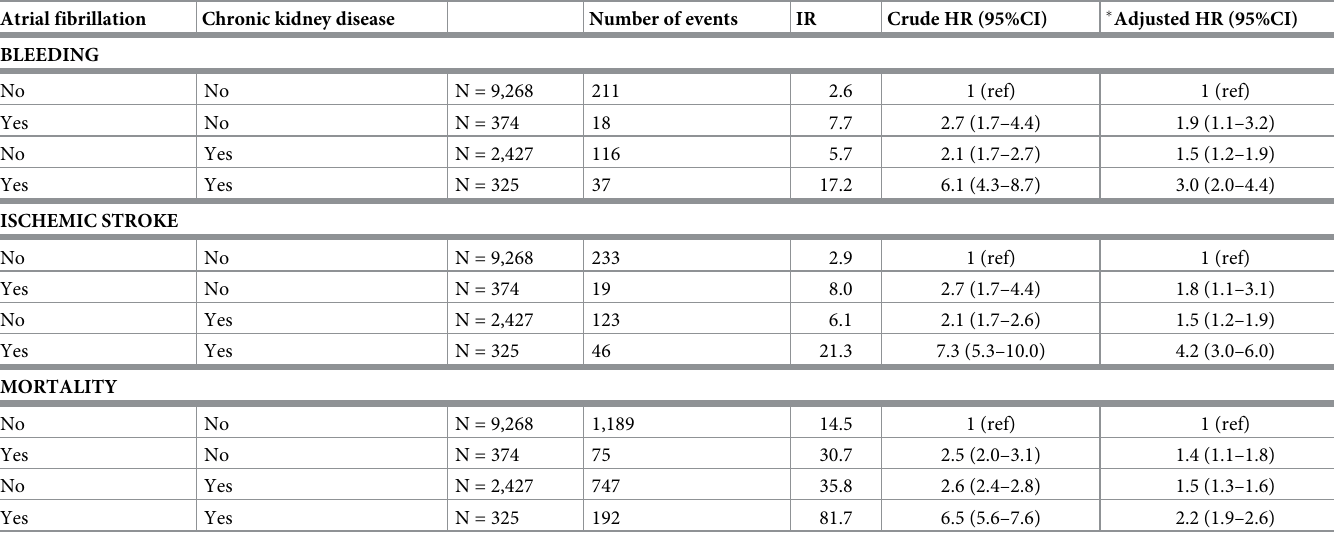
Table 2. Combination of atrial fibrillation and chronic kidney disease and risk of bleeding, ischemic stroke and mortality. Atrial fibrillation Chronic kidney